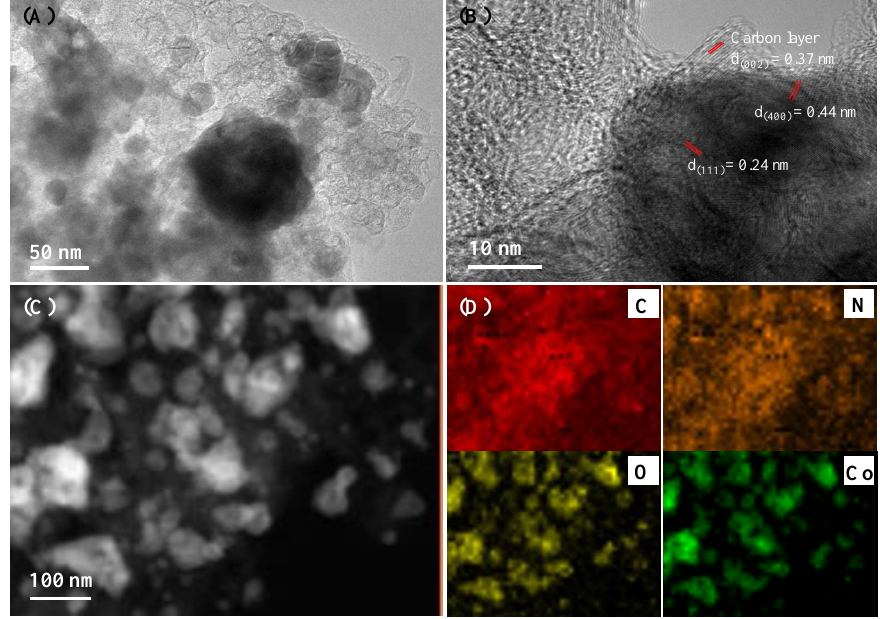
Figure 4. ( A , B ) HR-TEM images, ( C ) HAADF-STEM image, and ( D ) corresponding element mappings of